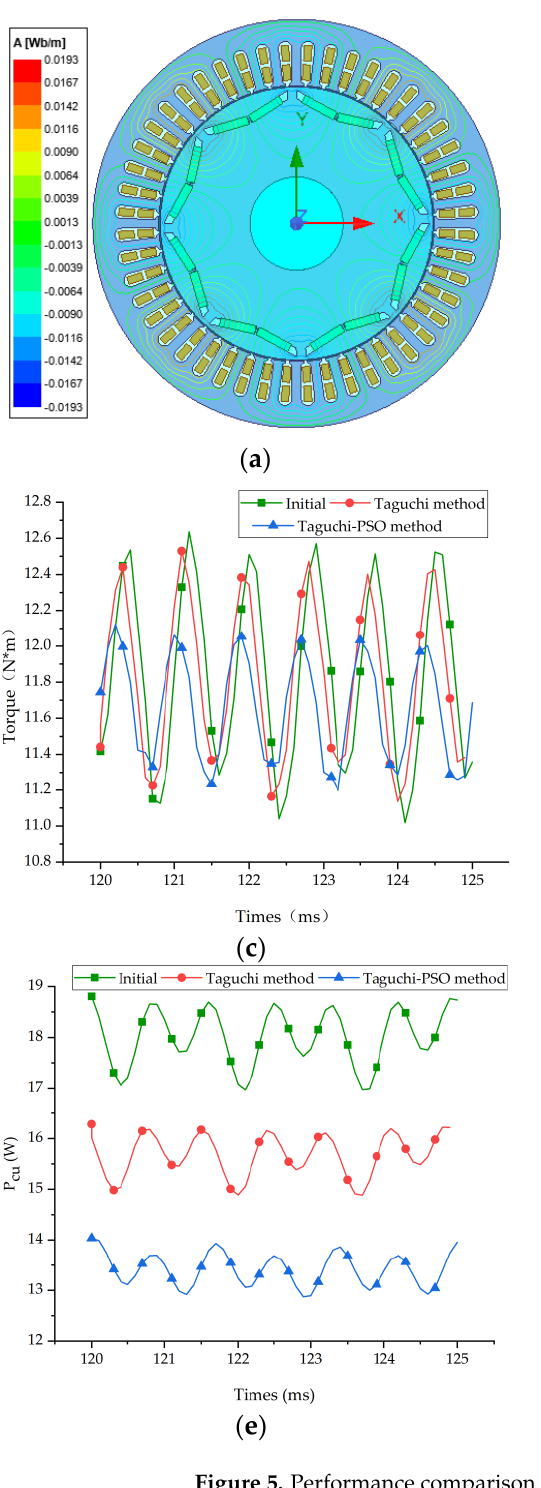
of IPMSM; ( b ) magnetic field density of IPMSM; ( c ) comparison of torque ripple; ( d ) comparison of core